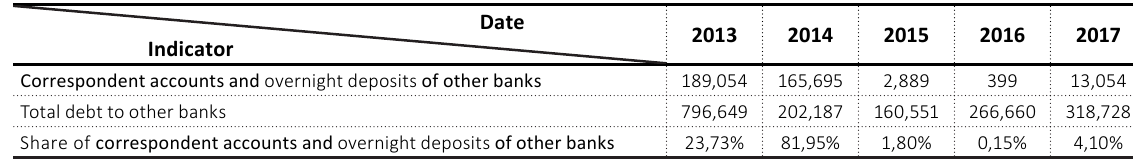
Table 4. Correspondent accounts and overnight loans of other banks, UAH